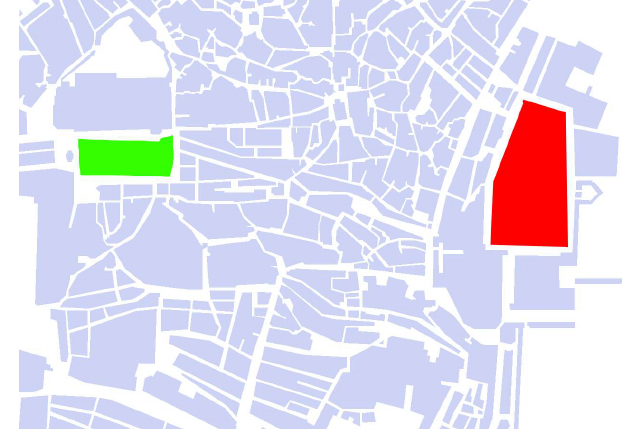
Figure 1: City of Lisbon before the 1755 earthquake, the departure zone in green and the arrival zone in